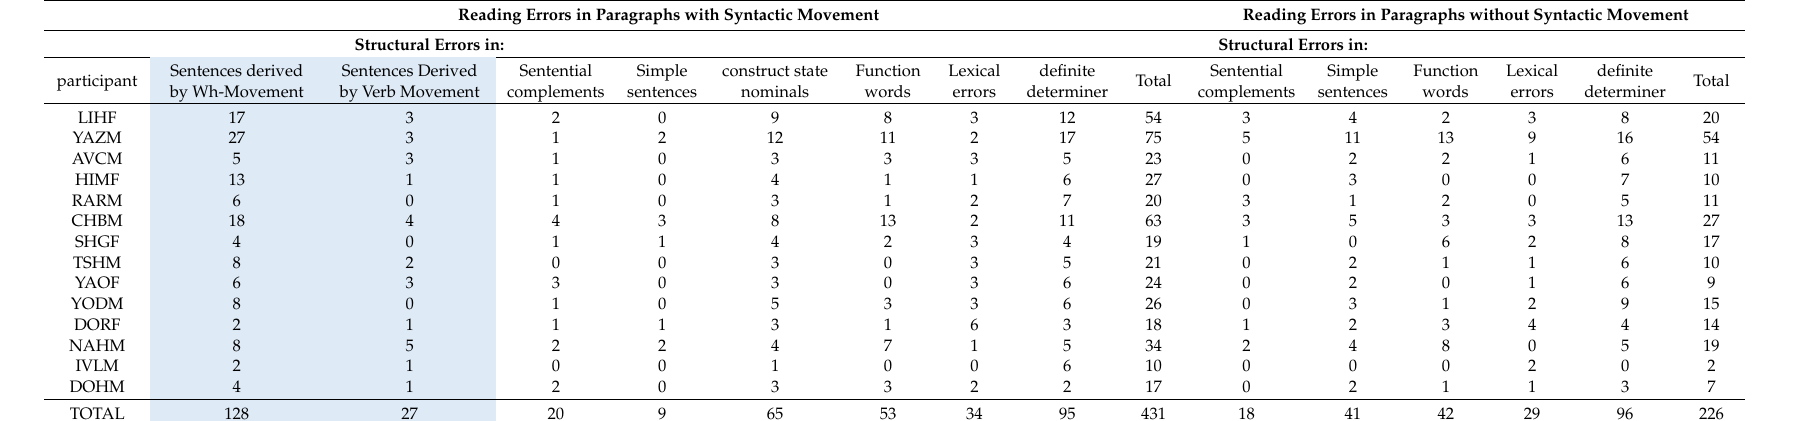
Shaded columns refer to two structures that occur in the paragraphs with movement and not in the paragraphs without